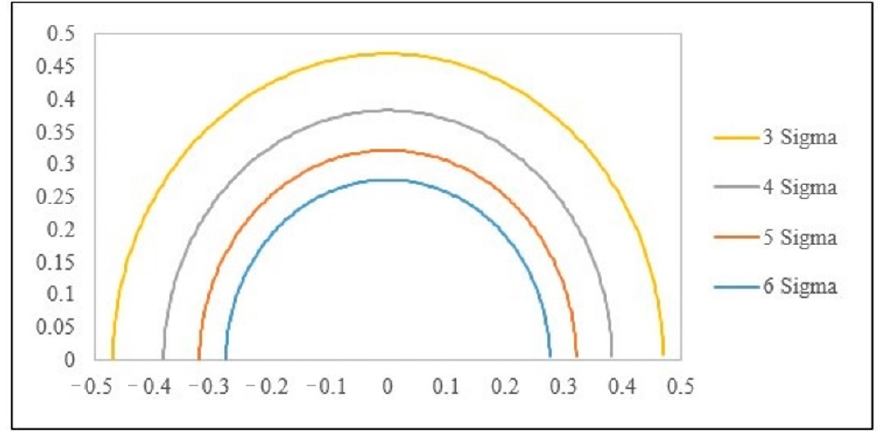
Figure 11. Multiple-quality characteristics process capability analysis chart (MPCAC/C pm ).